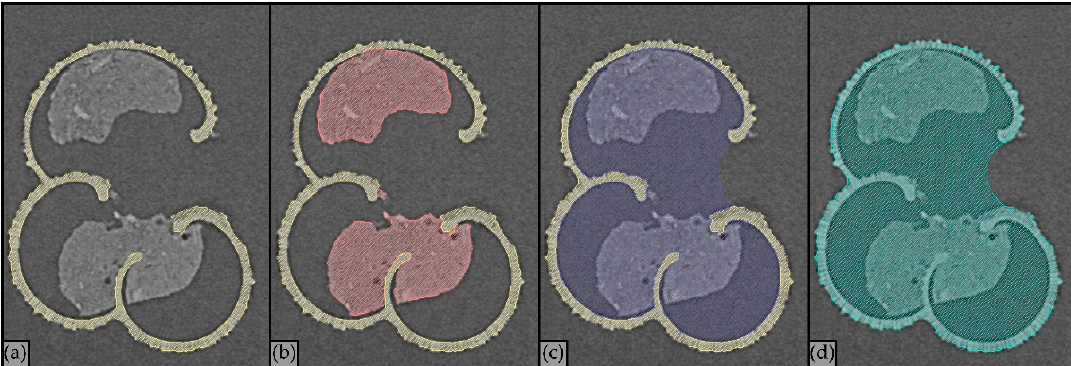
Figure 2. Example of tomograph segmentation using computed tomography (CT) data visualization software, where ( a ) in yellow , the foraminifera test is solely segmented; ( b ) in red, the area covered by dirt was also segmented; ( c ) dirt and internal (chamber) voids were considered together to calculate the area that was occupied by protoplasm (in blue); and ( d ) protoplasm and shell areas were merged together (in cyan) to calculate the total volume occupied by a foraminifer.